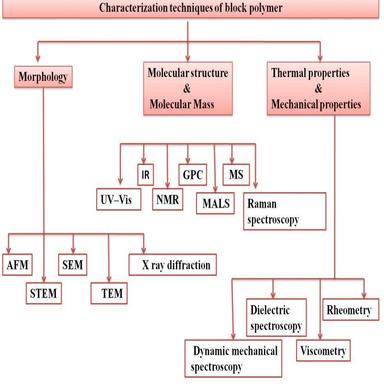
General methods for the preparation of polymeric nanoparticles of PEG-PCL.